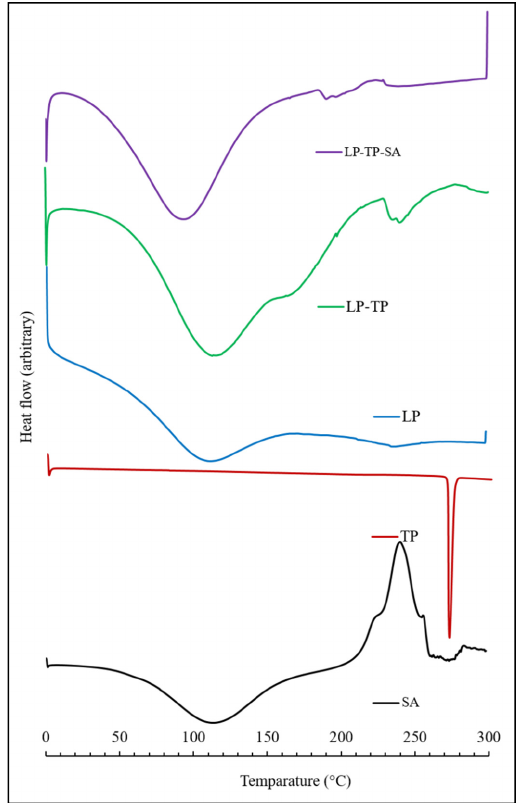
Figure 9. Thermograms of SA, TP, LP, LP-TP and LP-TP-SA.